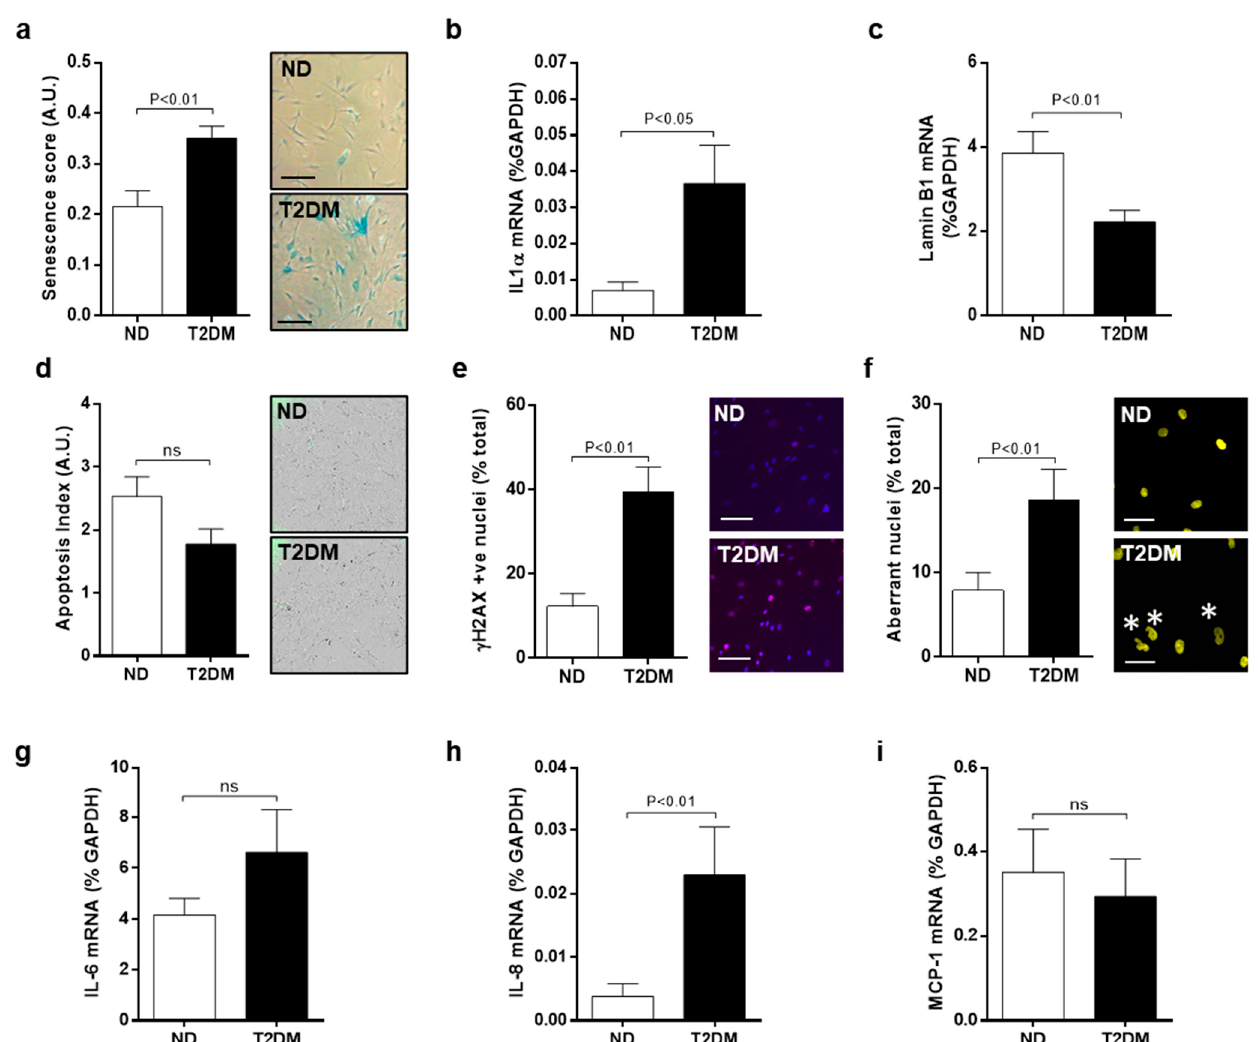
Figure 1. T2DM-SMC exhibit senescent features. ( a ) SMC were cultured in full growth medium for 48 h, fixed and stained for senescence-associated β -galactosidase (blue precipitate, scale bar = 200 µ m, n = 7). ( b ) RNA was extracted from cells cultured for 24 h and expression of senescence-associated markers IL-1 α and ( c ) LMNB1 measured by RT-PCR ( n = 8). ( d ) SMC were cultured in full growth medium for 48 h, fixed and incubated with NucView 488 caspase 3 substrate (to indicate apoptotic cells, n = 4), ( e ) stained for early DNA damage marker γ H2AX (pink foci, scale bar = 100 μ m, n = 8), and ( f ) DAPI to visualise aberrant nuclei (denoted by asterisk, scale bar = 50 μ m, n = 8). Basal expression of senescence-associated inflammatory genes ( g ) IL-6 , ( h ) IL-8 and ( i ) MCP-1 was measured using RT-PCR (all n = 8).